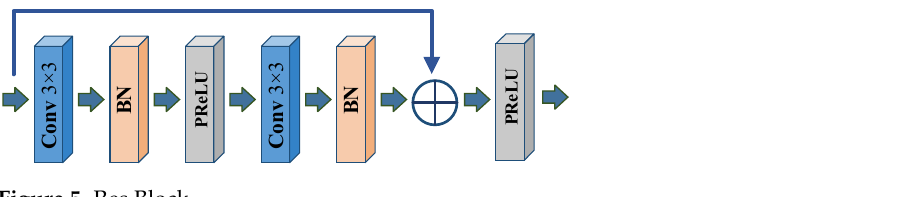
Figure 4. Improved U-net network structure.